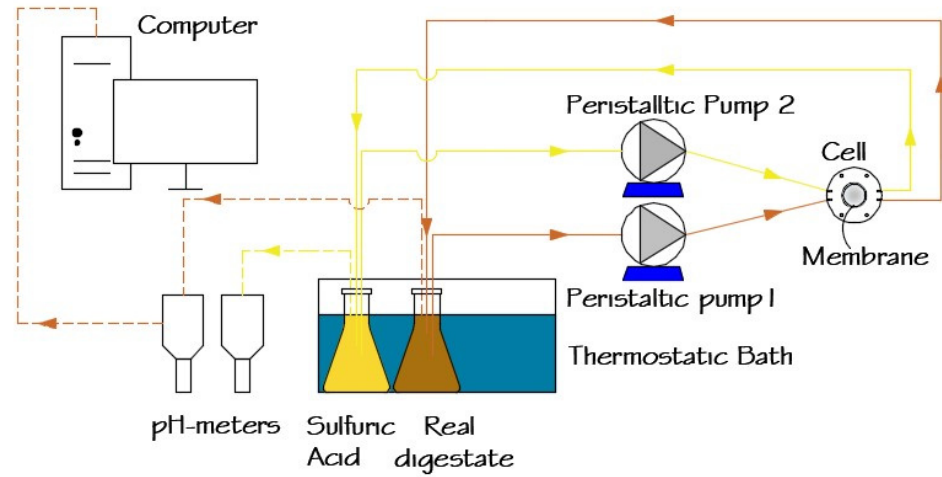
Figure 1. Schematic representation of the lab scale ammonia recovery system.